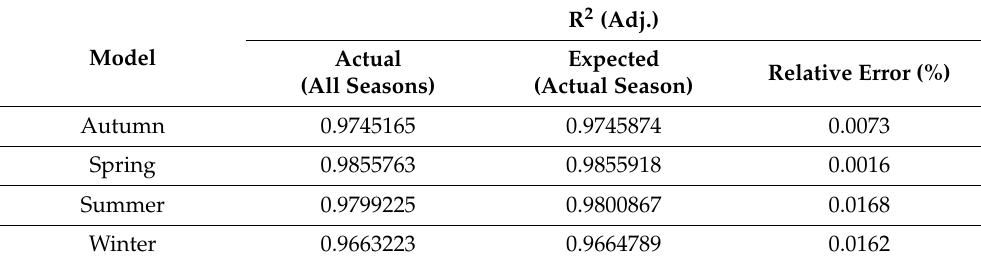
Table 5. Comparison of actual and expected R 2 (Adj.) for the selected RoomCL models.